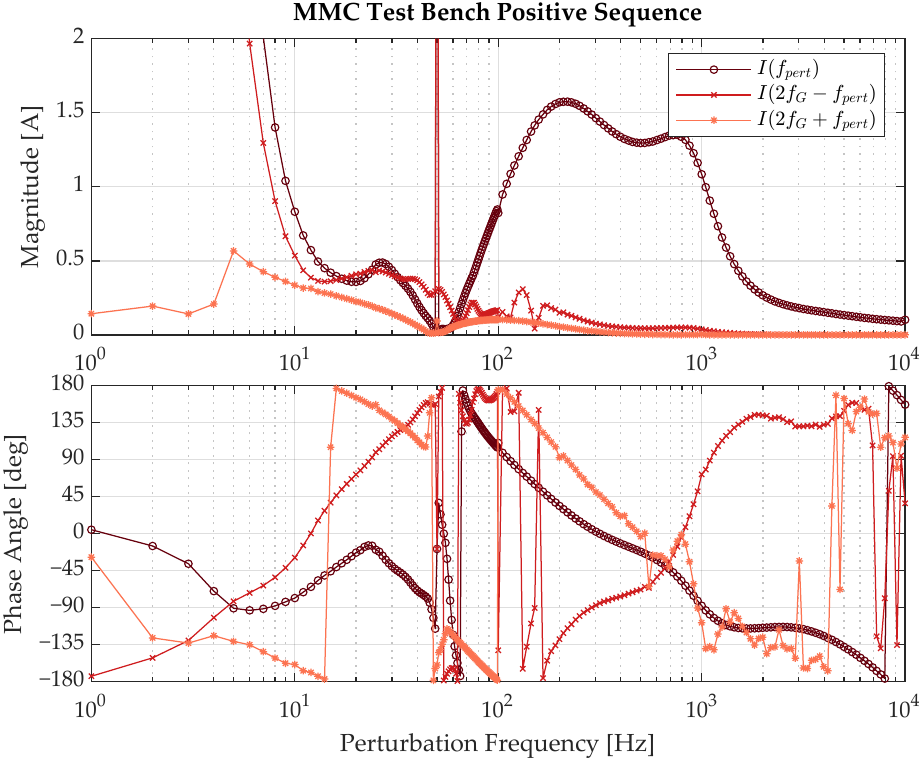
Figure 15. MMC TB current response to a voltage perturbation with frequency f pert .